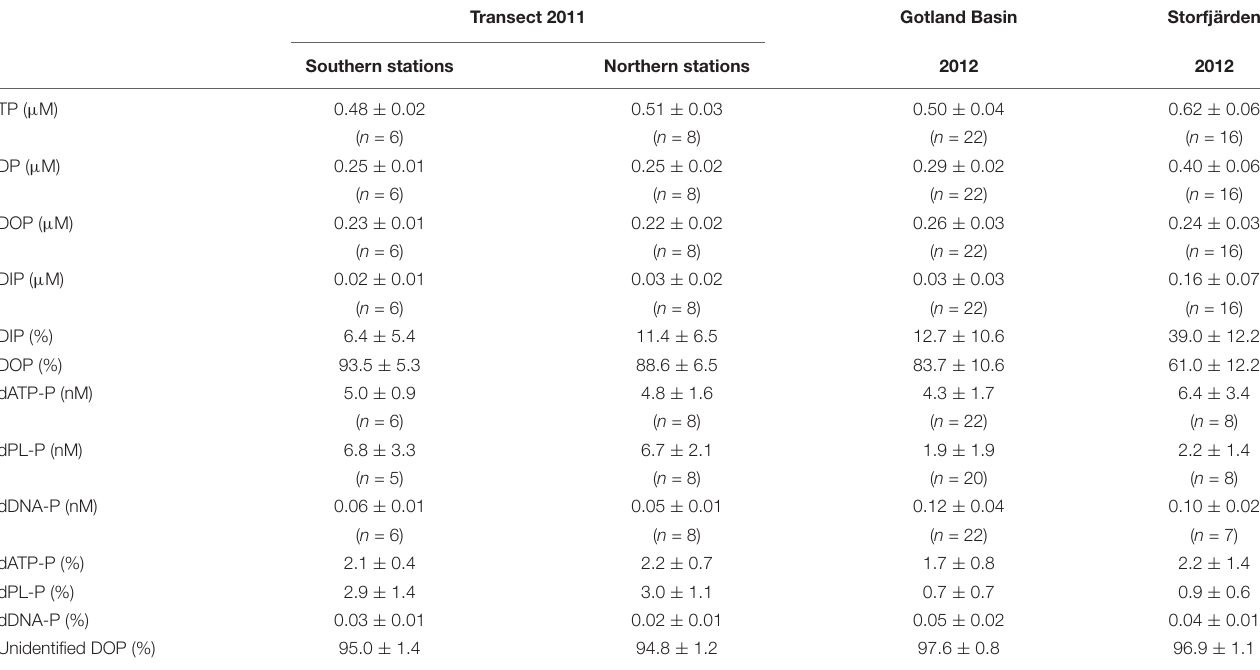
TABLE 2 | Mean concentrations and standard deviation of P-pool sizes, its contribution to total dissolved phosphorus (DP), and the contribution of single components (dATP-P, dPL-P, dDNA-P) to the DOP pool in three studies conducted in the Baltic Sea (n, number of data).